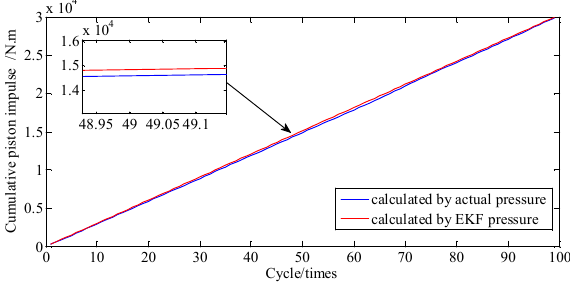
Figure 17. Piston impulse accumulated at A/F ratio 0.95.